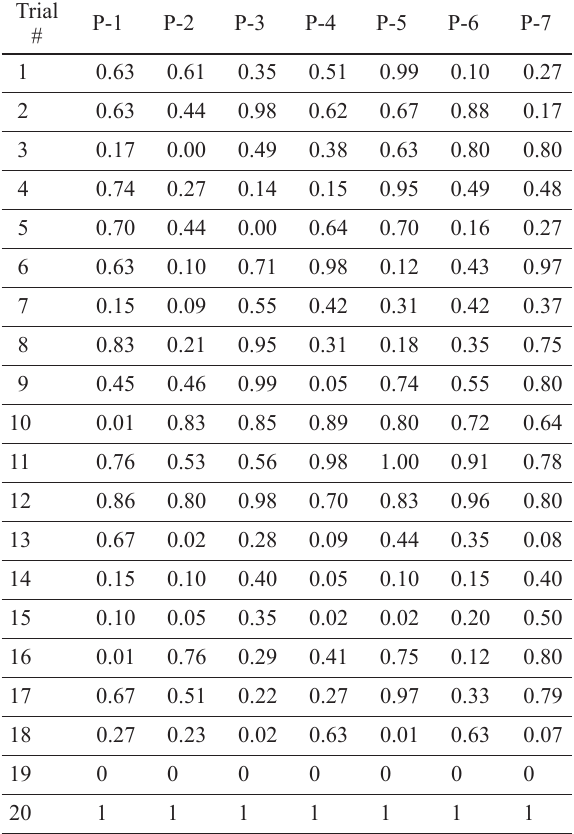
Table 11. Probabilities used to analyse the case study Trial #